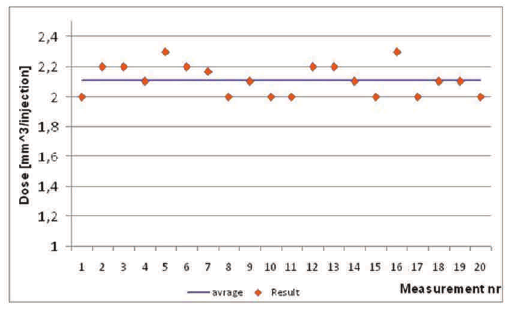
Fig. 5. Outlines of VE test after test